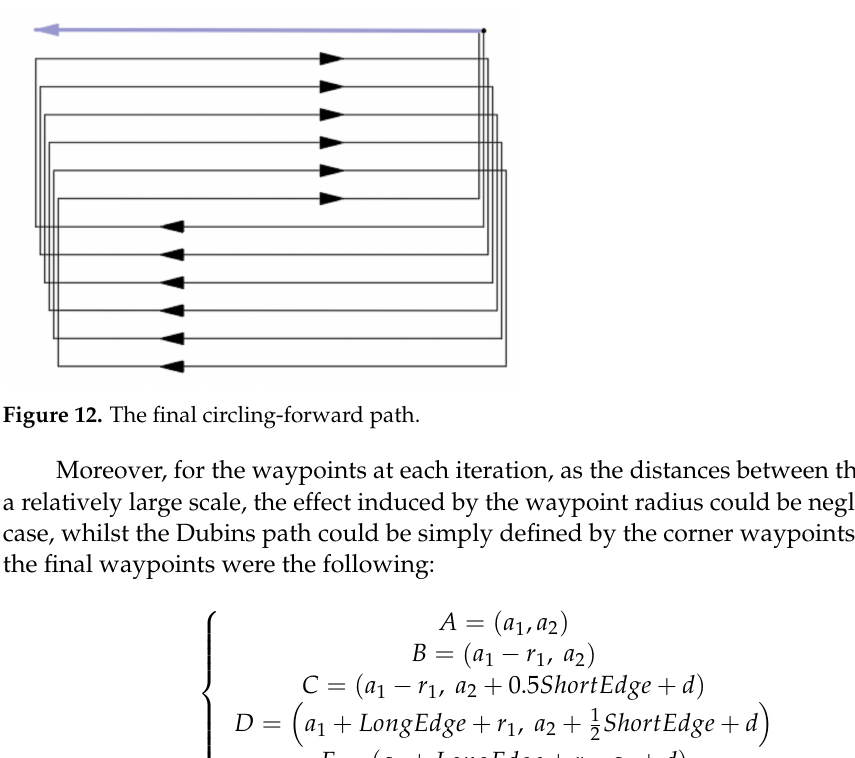
Figure 11. One iteration of the circling-forward path.